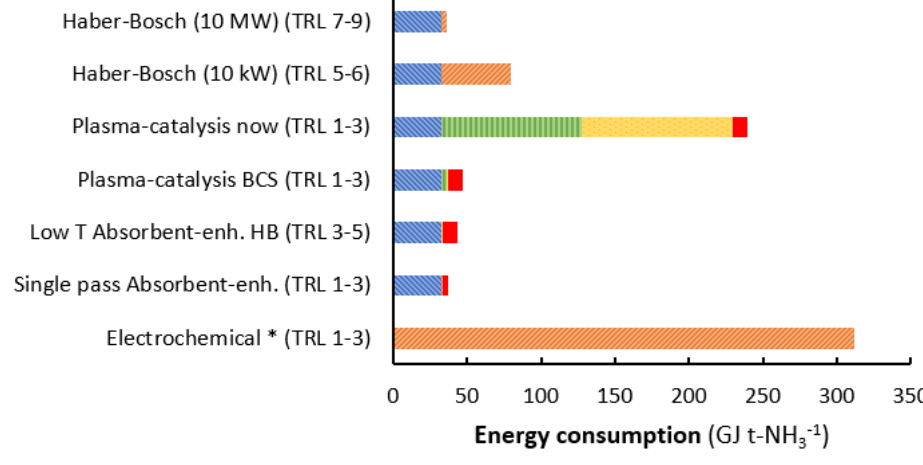
Figure 9. Estimated energy consumption of state-of-the-art small-scale, electrolysis-based Haber-Bosch, plasma catalysis (also best-case scenario), absorbent-enhanced Haber-Bosch, single pass process absorbent-enhanced process, and electrochemical ammonia synthesis. Estimates based on [16,67,107,108]. For plasma catalysis, the energy consumption for gas recycling and ammonia separation is based on estimates in for low pressure (1.5 bar), low conversion (0.4 mol. % NH 3 ) systems with solid sorbents (see also Section 3.1) [16,67]. * For electrochemical ammonia synthesis, only the energy consumption of ammonia production is included and the energy cost of ammonia separation and recycling is not included. TRL stands for technology readiness level. The TRL levels here apply for the complete system. TRL 1 is the basic idea, while TRL 9 is a commercial system. For more details, see ref. [68].